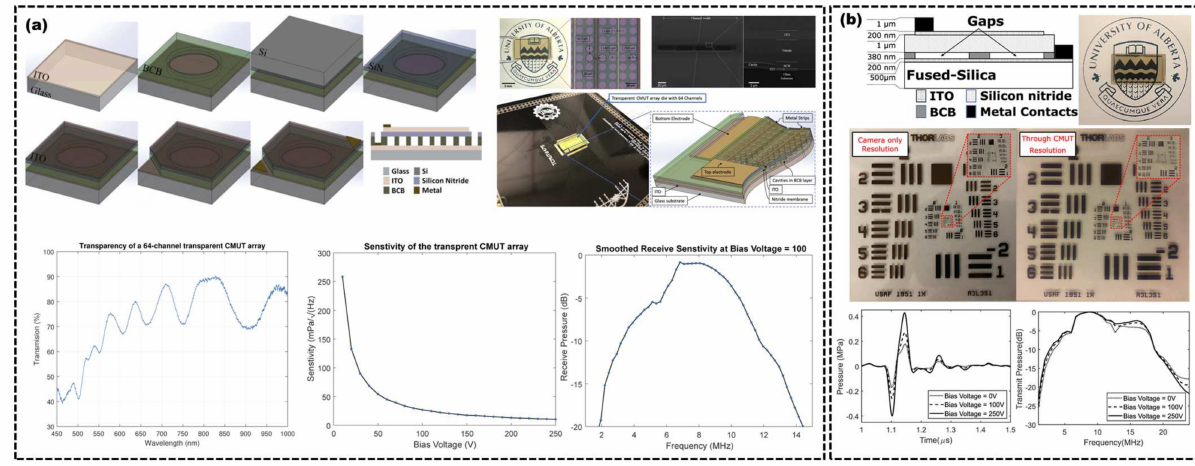
Figure 3. Transparent CMUT arrays: ( a ) Fabrication process flow (upper left), photos and 3D drawing (upper right), transparency (lower left), receive sensitivity versus bias voltage (lower middle), and frequency response (lower right) of a transparent CMUT array with 64 channels. ITO: Indium Tin Oxide, BCB: benzocyclobutene. Adapted with permission from ref. [34]. Copyright 2020 Optical Society of America; ( b ) Cross-sectional structural drawing (upper left), photo (upper right), transparency demonstration by a camera resolution test (middle), acoustic pressure generated with a single element (lower left), and frequency response (lower right) of a 9 MHz transparent CMUT linear array with 128 elements. Adapted with permission from ref. [33]. Copyright 2021 Optical Society of